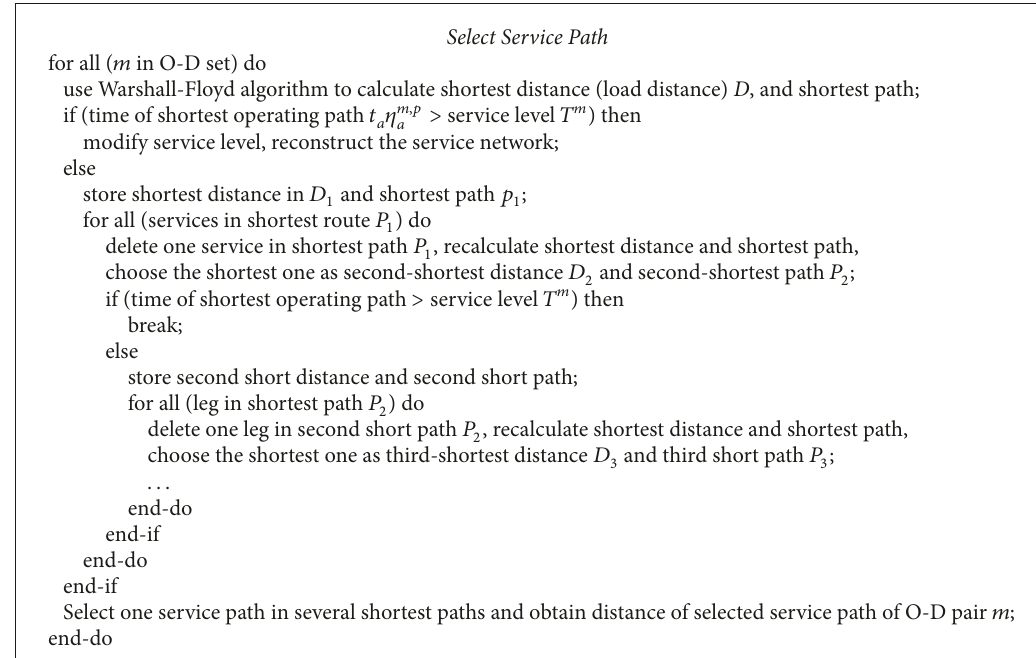
Pseudocode 2: Pseudocode for service path